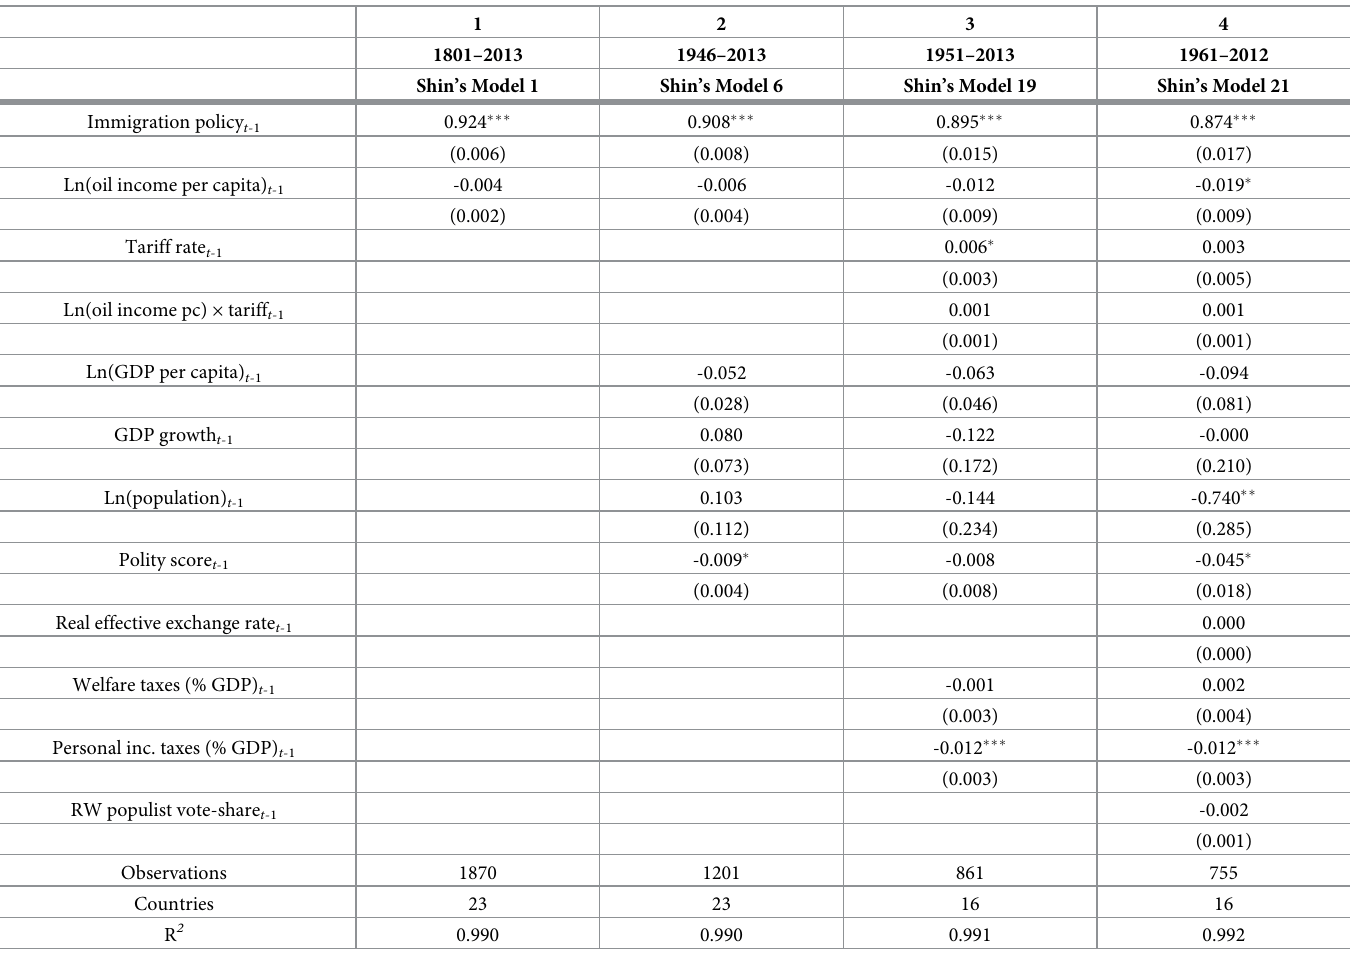
Table 2. Oil wealth and immigration policy: Norway